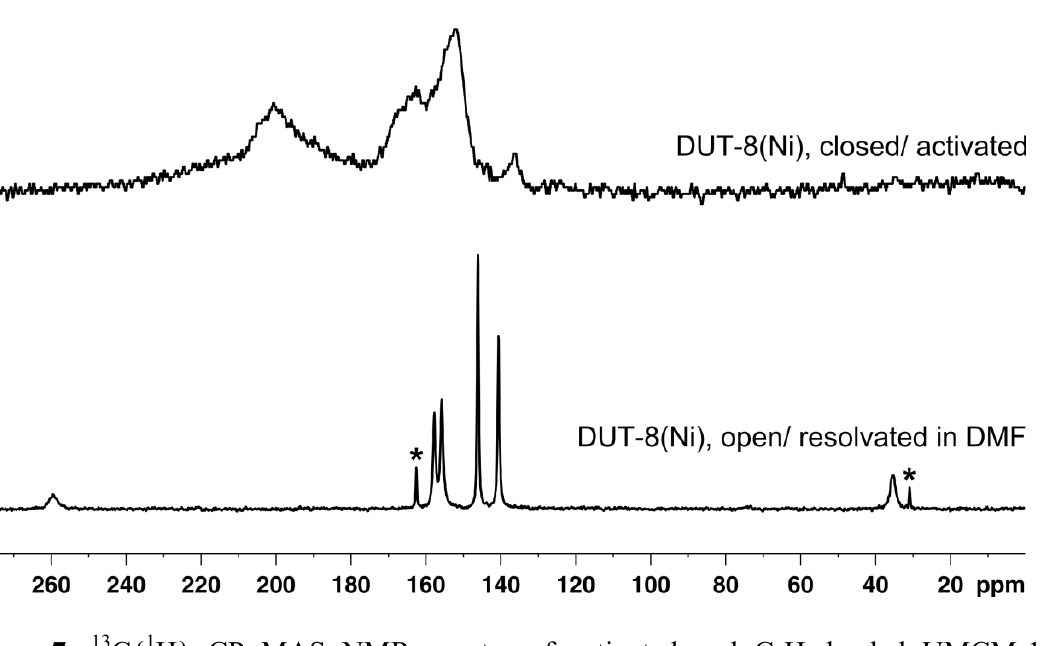
H -loaded UMCM-1, 6 6